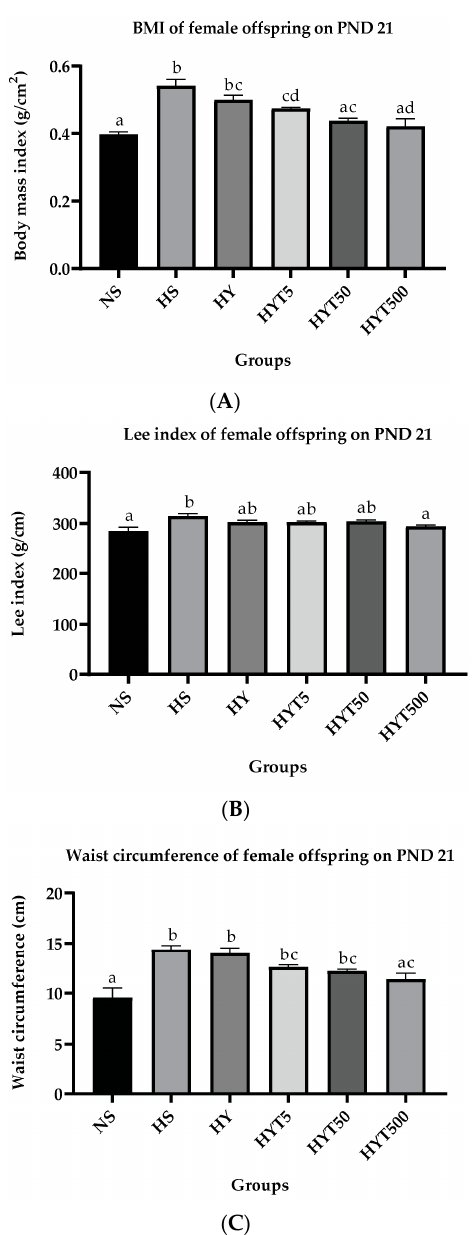
Figure 2. ( A ). Body mass index of female offspring on PND 21. ( B ). Lee index of female offspring on PND 21. ( C ). Waist circumference of female offspring on PND 21. NS: normal chow and saline; HS: HFD and saline; HY: HFD and yoghurt; HYT5: HFD and 5 mg/kg of E. tapos yoghurt; HYT50: HFD and 50 mg/kg of E. tapos yoghurt; HYT500: HFD and 500 mg/kg of E. tapos yoghurt. Values are expressed as mean ± SEM. Different letters indicate a significant difference at p < 0.05.